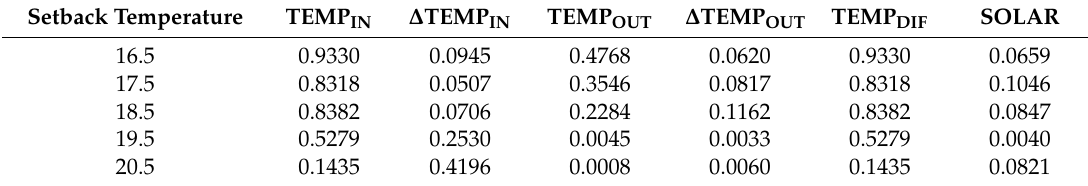
Table 5. Statistical correlation (R 2 ) between input and output variables of the ANN model.